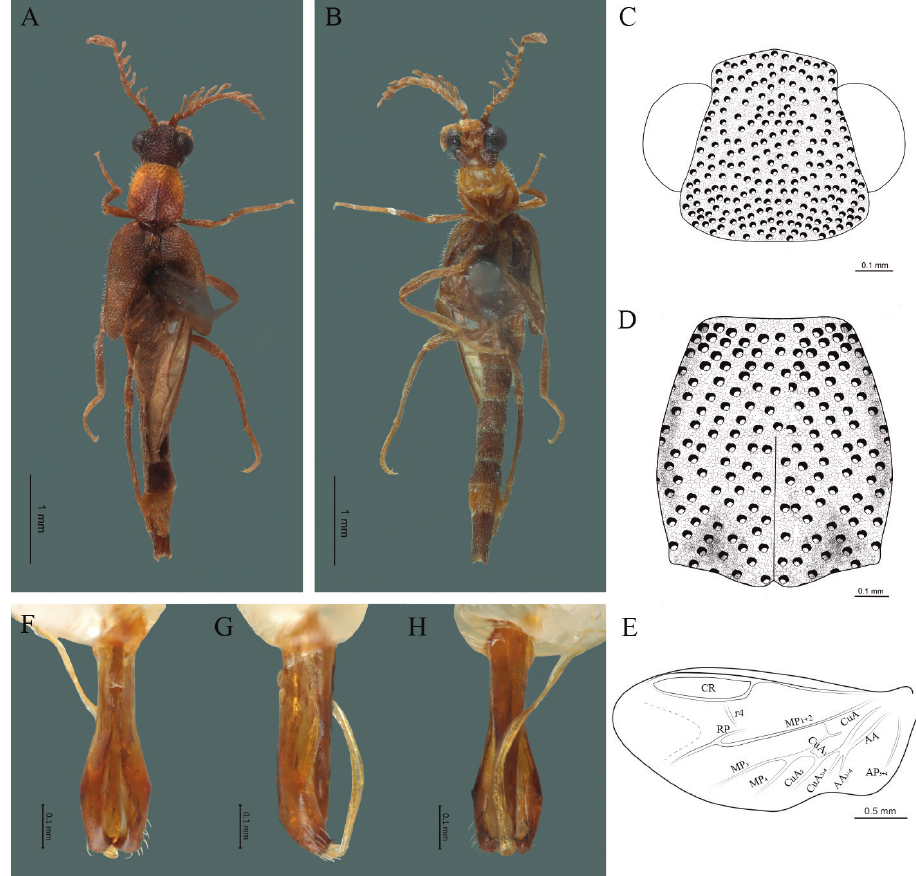
Figure 7. Cenophengus cuicatlaensis Zaragoza-Caballero, 2008, male. Habitus: A dorsal B ventral C head dorsal D pronotum dorsal E hind wing. Wing venation: CR = Radial Cell; r4 = radial 4 vein; RP = Posterior Radial vein; MP1+2 = Posterior Median vein; CuA = Cubital vein; AA and AP = Anterior and Posterior Anal veins. Aedeagus: F dorsal view G lateral view H ventral